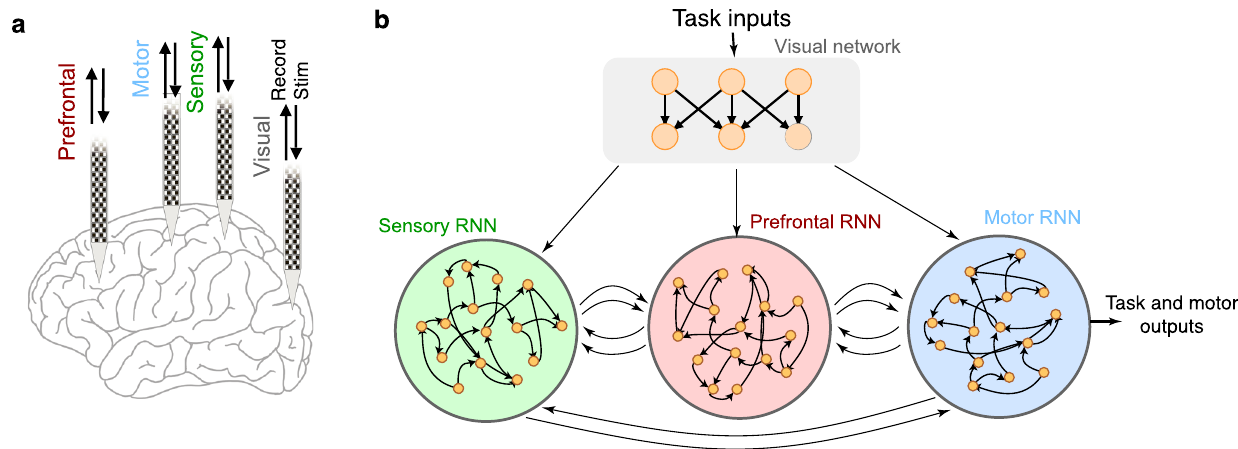
Fig. 2 Using neural networks to model multi-area computation. a Multi-area, brain-wide electrical recording and stimulation of neural activity is rapidly becoming possible, and these data require new analyses and modeling to provide new scienti fi c insights and theories of neural computation. High-density NeuroPixel electrodes are shown inserted in four locations, and many additional insertions are possible in both cortical and subcortical regions 9 . Each insertion can access several different brain areas (M). Thus the size of the data is proportional to N × M. The proportionality constant depends on the type of neural recordings, with full broadband data including low-frequency local fi eld potentials (LFPs) and action potentials (APs, or spikes) requiring the fastest sampling. For stimulation, it is possible to stimulate arbitrary waveforms on each electrode in each area and thus there are enormous combinatorial possibilities 39 . Single and two photon optical imaging of genetically encoded calcium indicators and voltage indicators, and optogenetic neural modulation, are also widely used but are not shown for simplicity. b Multi-area RNNs can be trained to model each of these insertions. Visual areas may be modeled via convolutional neural networks 40, 41 or related arti fi cial networks that incorporate recurrence. Areas like the prefrontal and motor cortex are typically modeled by RNNs 6,30 . Regularizations may be employed so that activity within an RNN area resembles those recorded from each electrode array